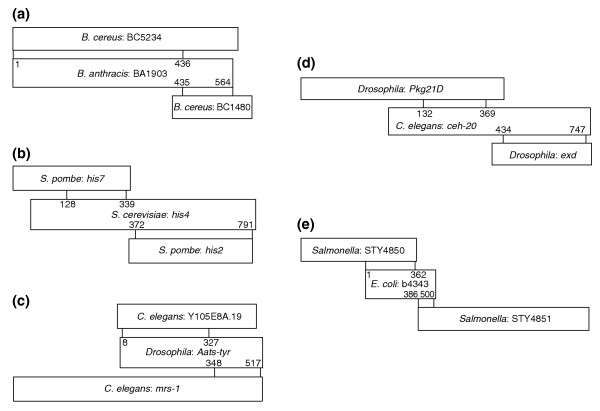
Representative examples of shuffled genes identified. (a) Bacillus anthracis M23/M37 peptidase BA1903, the result of a domain exchange between B. cereus genes BC5234 (12098), a N-acetylmuramoyl-L-alanine amidase and BC1480(08460.1), another M23/M37 peptidase. (b) A fusion of the fission yeast genes his7 (a phosphoribosyl-AMP cyclohydrolase) and his2 (a histidinol dehydrogenase) to produce the budding yeast his4 gene, which is involved in histidine biosynthesis. The budding yeast gene appears to combine the functions of the two fission yeast genes [35]. (c) The fruit fly gene Aats-tyr is a tyrosyl-tRNA synthetase (Flybase annotation) [36]. It is a probable recombination product of a predicted worm methionyl-tRNA synthetase gene mrs-1 (WormBase annotation) [37] and a second worm gene Y105E8A.19 of unknown function. (d) C. elegans gene ceh-20, which encodes a homeodomain protein. This gene appears to be the result of a domain exchange between the Drosophila genes exd (extradenticle, also a homeodomain protein) and Pkg21D (cGMP-dependant protein kinase). (e) E. coli b4343, a hypothetical protein apparently formed via a domain exchange between Salmonella genes STY4850 (annotated as a DEAD-box helicase-related protein) and STY4851 (hypothetical protein). The numbers in the recombinant gene box are amino-acid positions in the protein product, indicating the portion of the protein derived from each of its 'parental' proteins.